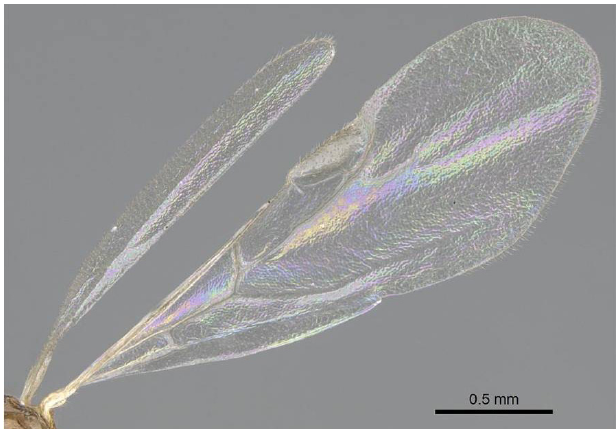
Fig 13 . Temnothorax ansei sp.n. male wings. Photo credit: Michele Esposito, from www.AntWeb.org,CASENT0919954_P_2, published with permission. and without spines, only with a very slight angle. Petiole low and with node rounded. Gaster smooth and shiny. Wings as queens. Variability: some males have the propodeum rounded.